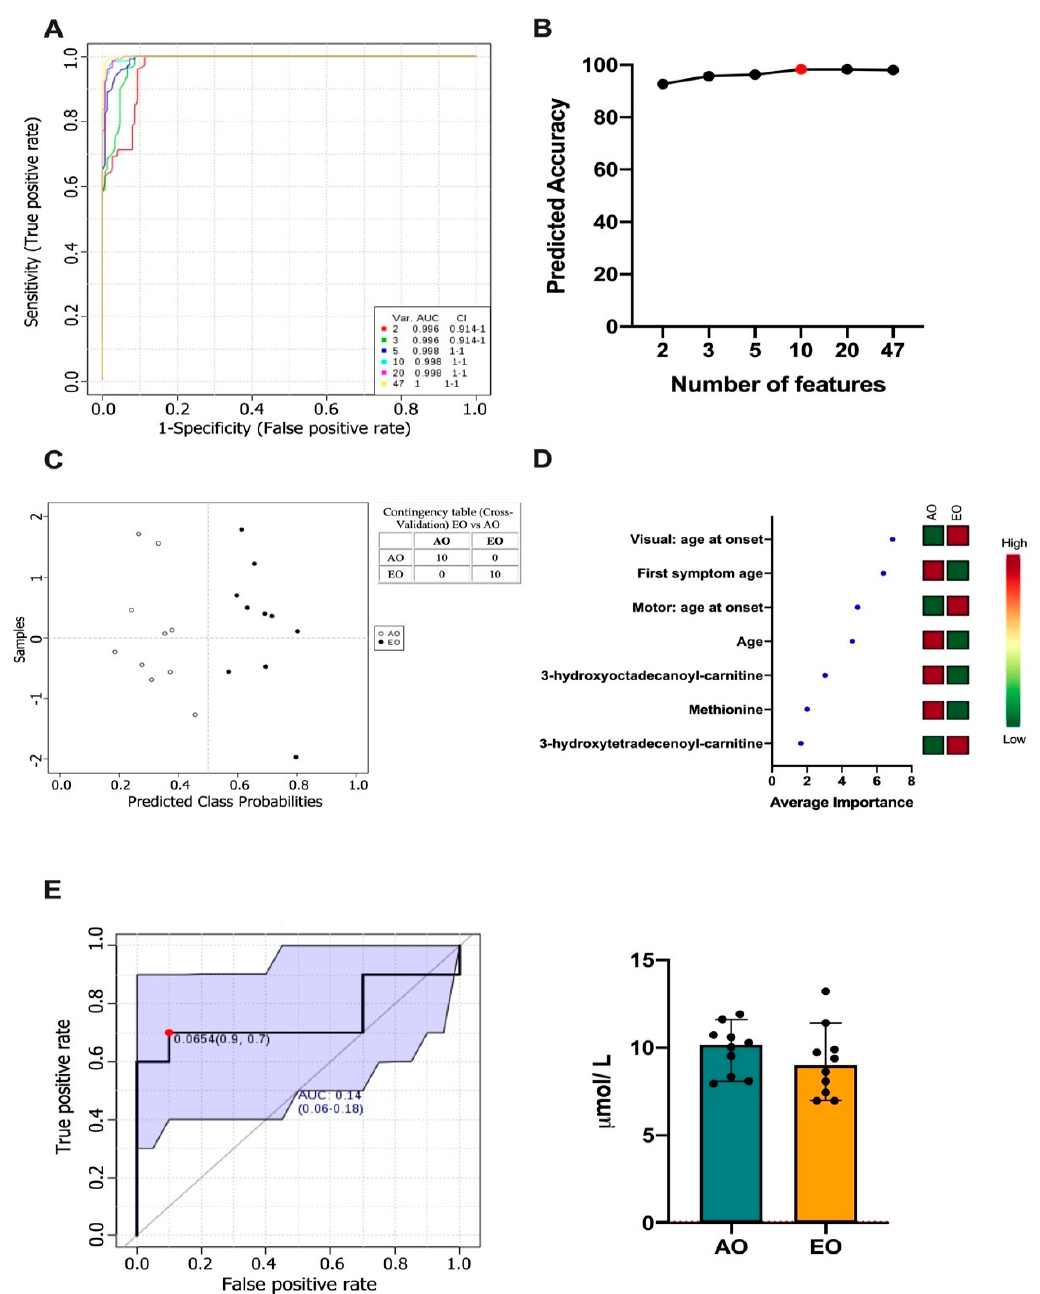
Figure 3. ( A ) ROC curves for all models based on its average performance; ( B ) Predictive accuracy of the biomarker models with an increasing number of features. The most accurate biomarker model is highlighted with a red dot; ( C ) Predicted class probabilities for all samples (Adult-Onset (open circle) and Early-Onset patients (filled circle)), using the created biomarker model. Because of a balanced subsampling, the classification boundary is at the center (x = 0.5, dotted line); ( D ) Plot of the most important features of a selected model, ranked from most to least important. ( E ) ROC curve of Methionine. The sensitivity is plotted on the y-axis and the specificity on the x-axis. The Area Under the Curve (AUC) is in blue. The image on the right corresponds to a boxplot of the two groups within the dataset. ROC analysis calculated by FRPmax (False positive rate).